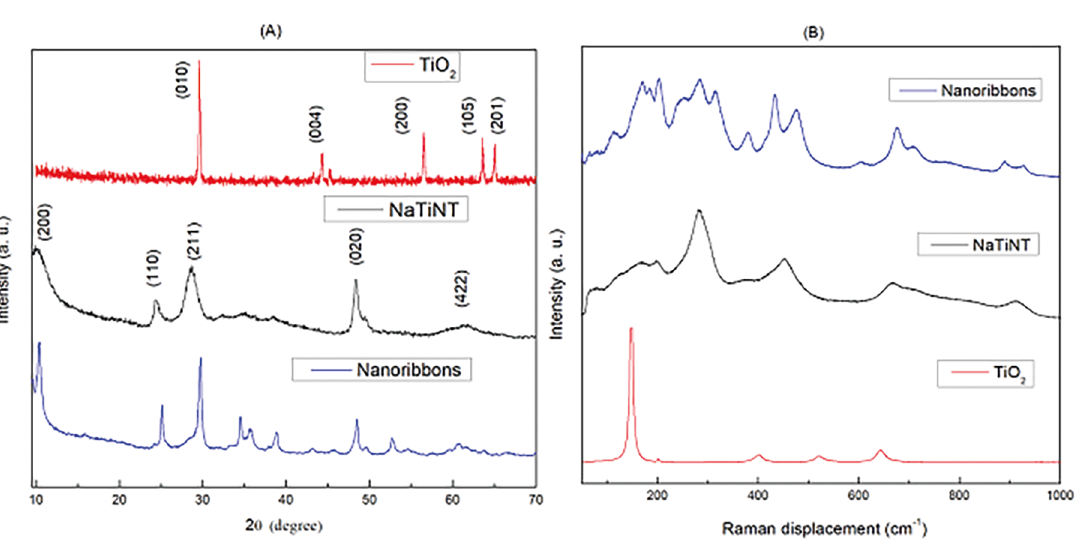
, NaTiNT and Nanoribbons powders; (B) Raman spectra of the NaTiNT, Nanoribbons and TiO 2